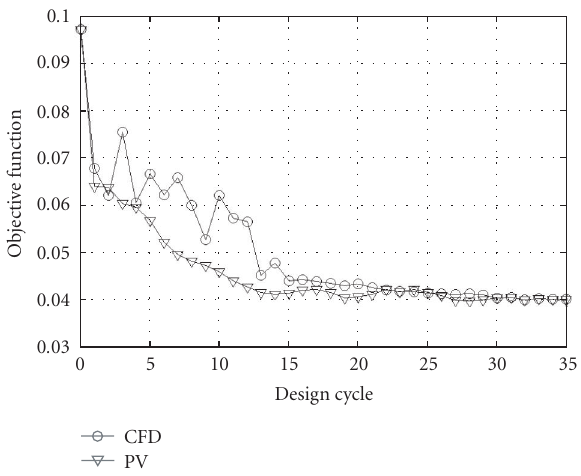
Figure 7: Evolution curve of objective function.